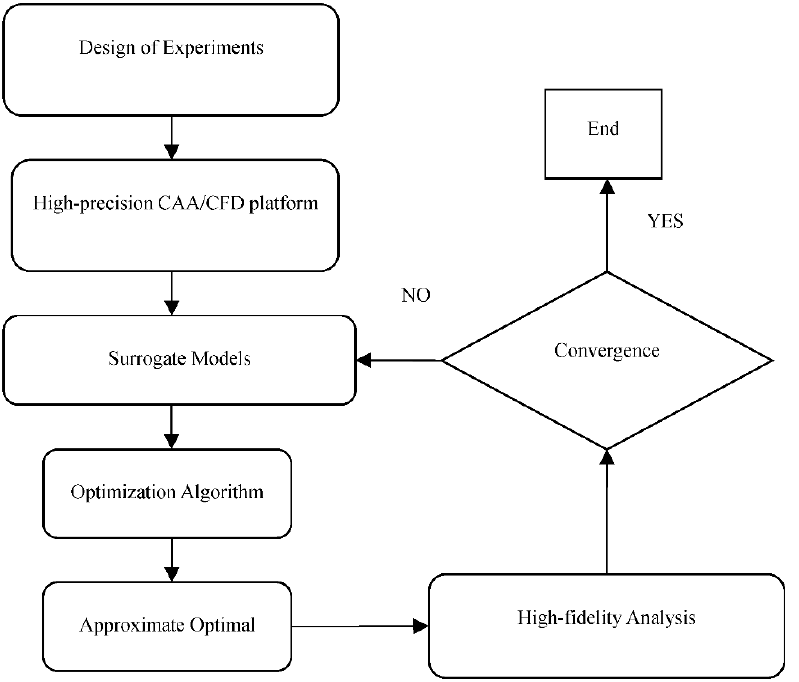
Figure 12. Framework of optimization process.